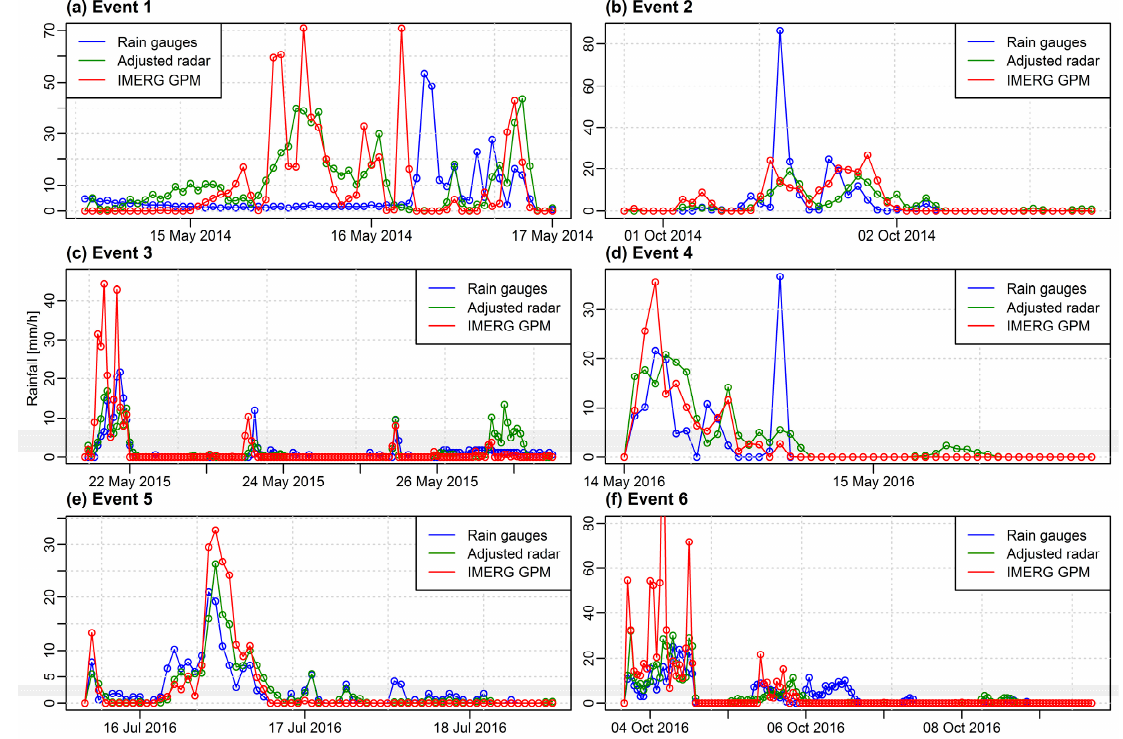
Figure 5. Comparison of the temporal distribution of 1-h rainfall accumulation (for the entire catchment) for rain gauges, adjusted radar, and IMERG GPM data during the analyzed events 1–6 ( a – f ). Table 6. Comparison of total precipitation for analyzed flood events.